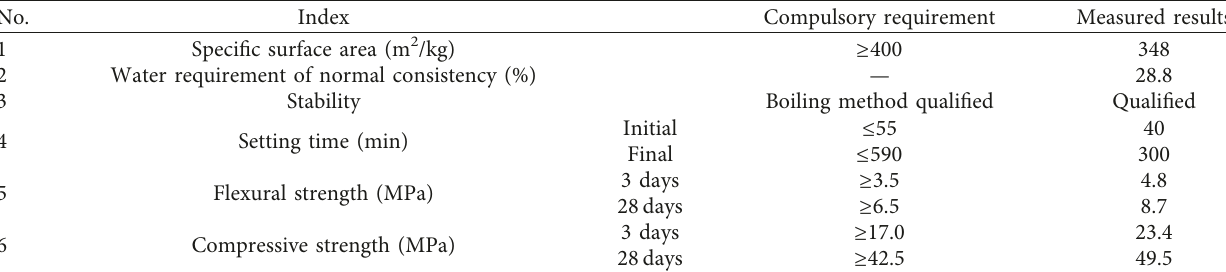
Table 1: Performances of cement used in the laboratory test.